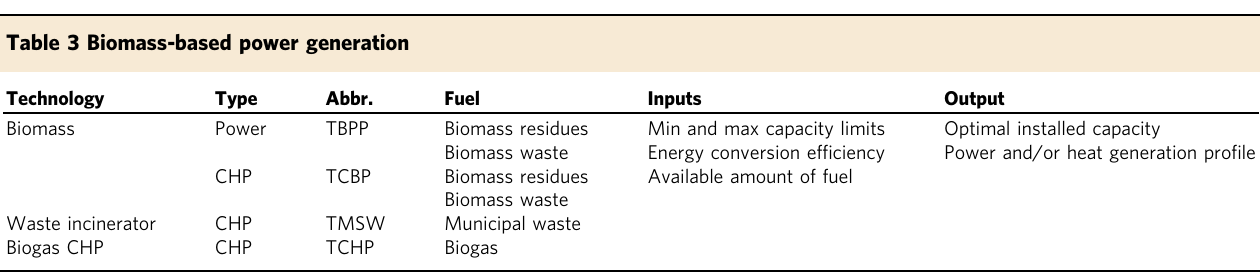
Table 3 Biomass-based power generation